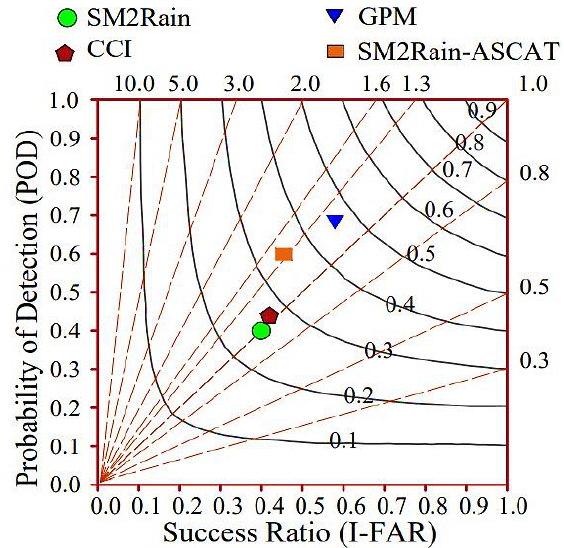
Figure 12. Performance diagram of all SPPs on daily scale .